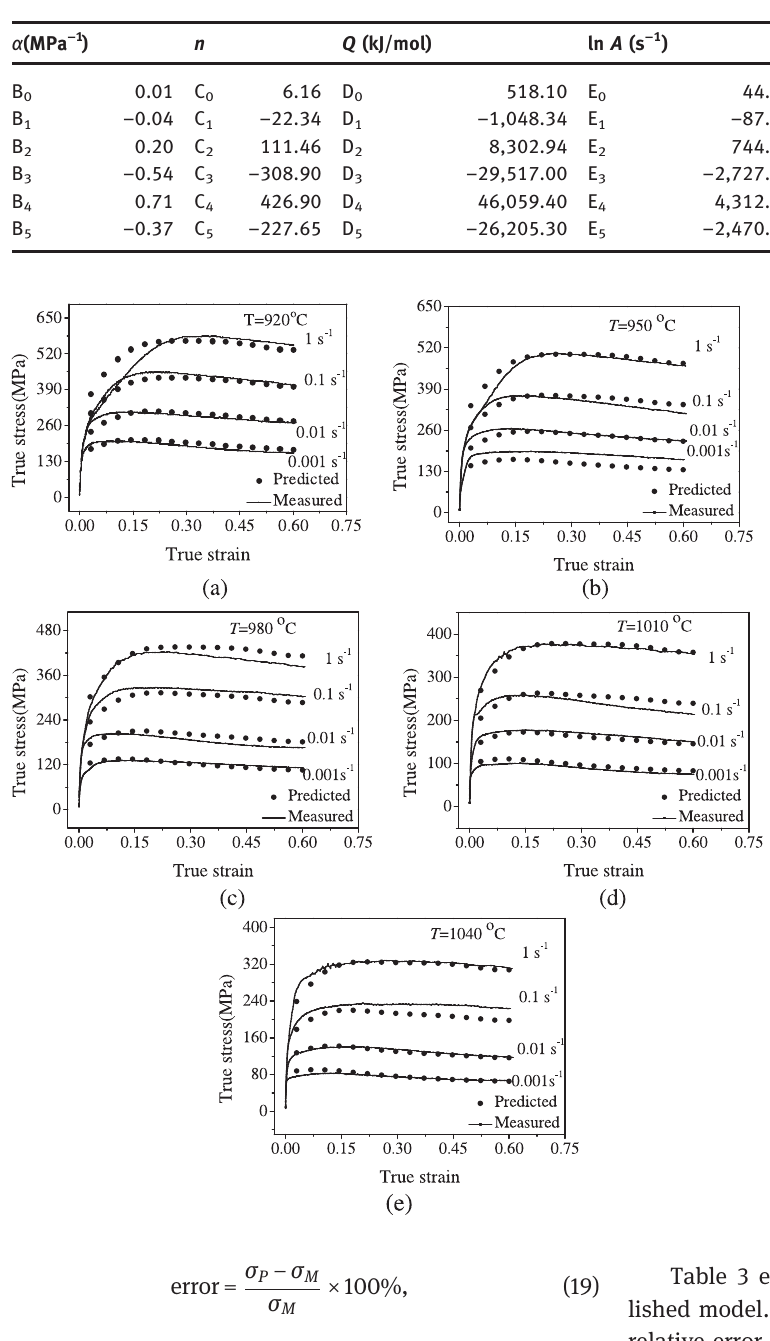
Figure 6: Comparisons between predicted and measured true stresses of the studied superalloy at the deformation temperatures of: (a) 920 °C; (b) 950 °C; (c) 980 °C; (d) 1010 °C; (e) 1040